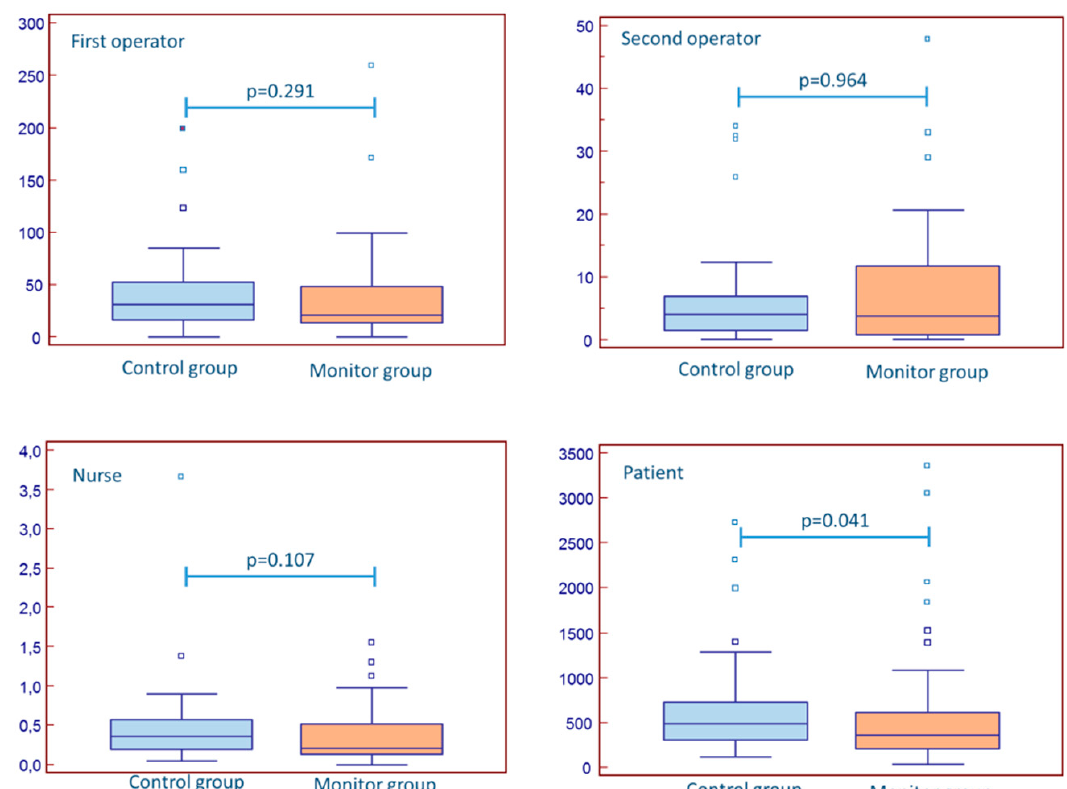
Figure 3. The impact of real-time monitoring in procedures >60 min.